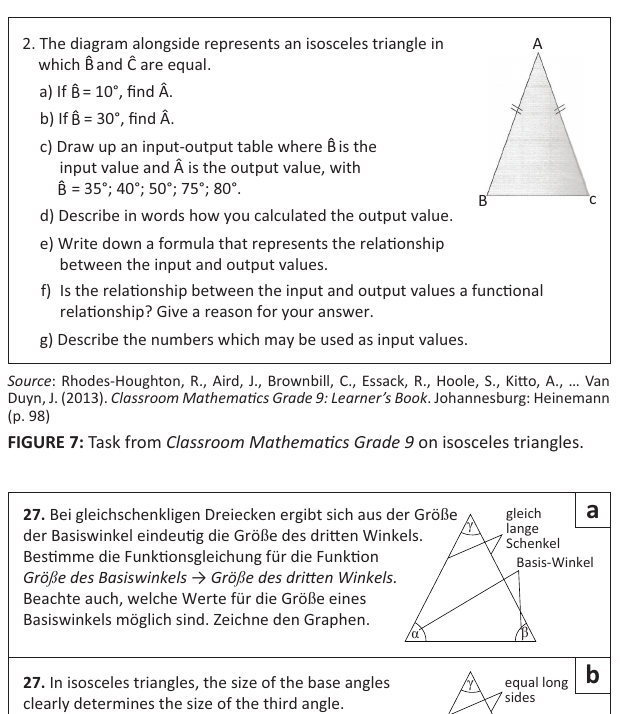
2. The diagram alongside represents an isosceles triangle in which and Ĉ are equal.